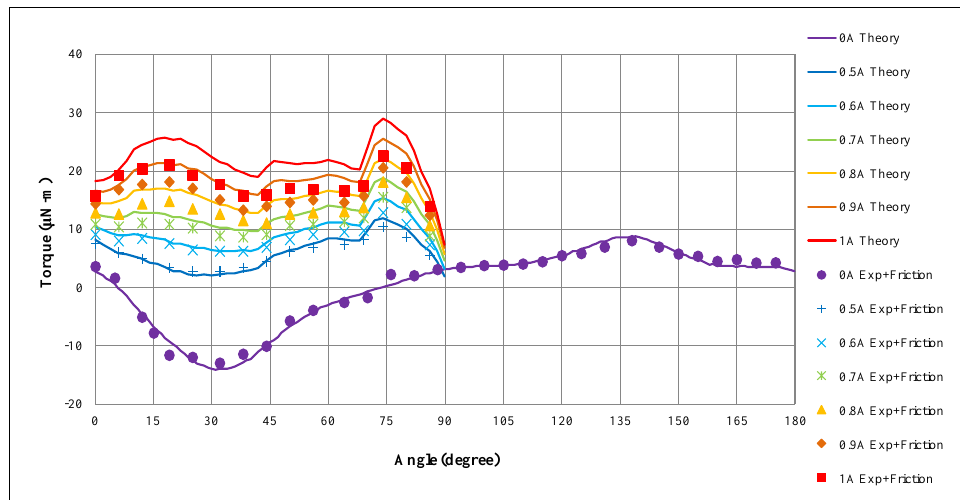
Figure 18. Theoretical and experimental torque-angle curves of the motor with friction correction.